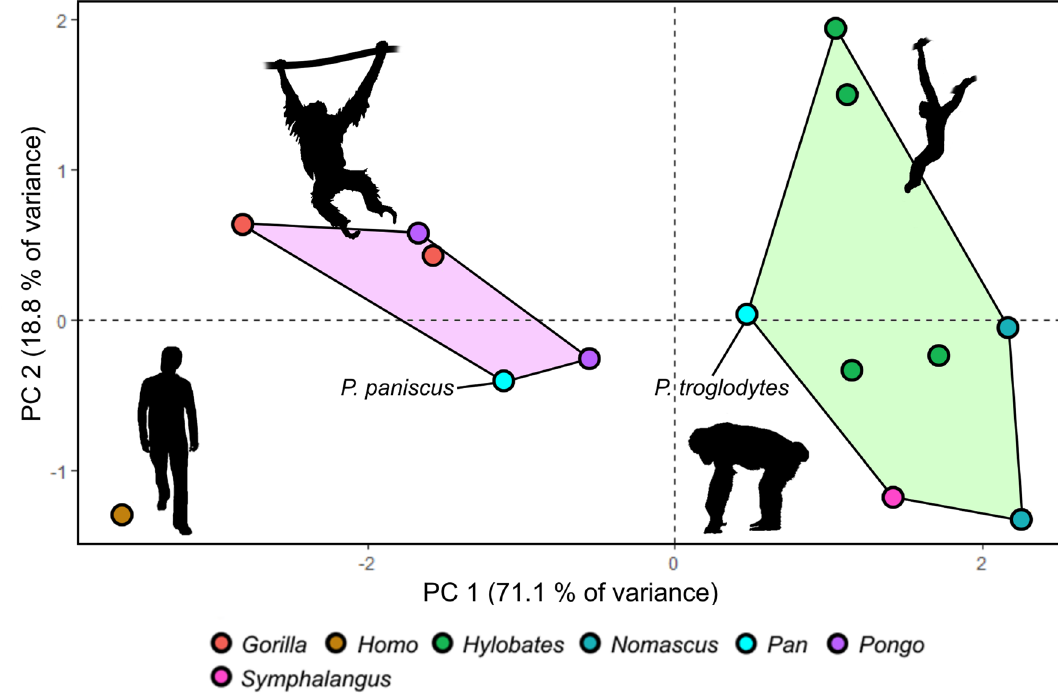
Figure 6. Results of PCA on quantified ocular traits in apes. ( A ) Visualization of PCA results. Chimpanzees and gibbons form a cluster highlighted in green. Gorillas, bonobos and orangutans cluster together in a morphospace colored in light purple. Humans are separated from all other hominoids. The orangutan silhouette is in public domain, others were created by